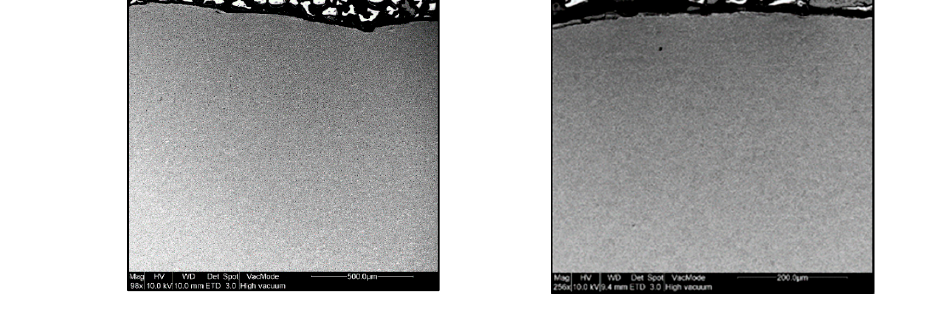
Table 3. Definition of parameters used for each sample and results.